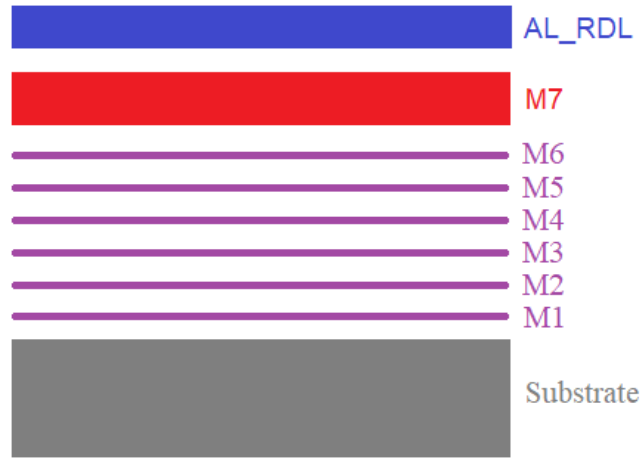
Figure 4. Metal layer stacks for UMC 40-nm CMOS